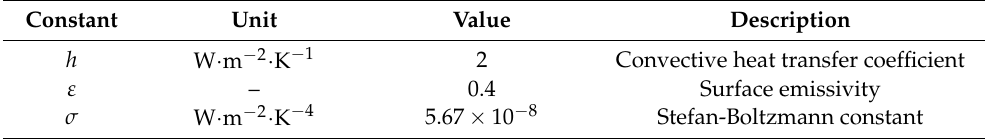
Table 2. Constant values used in boundary